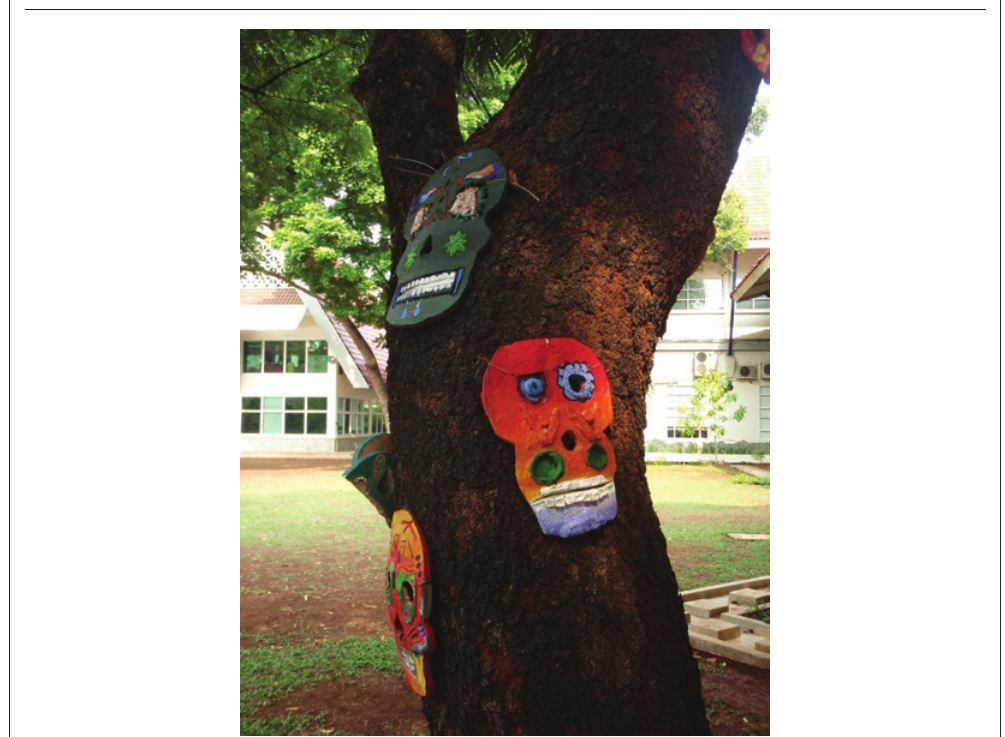
figure 3: Student art: indigenous masks (Source: elisabeth barratt Hacking, 2015)